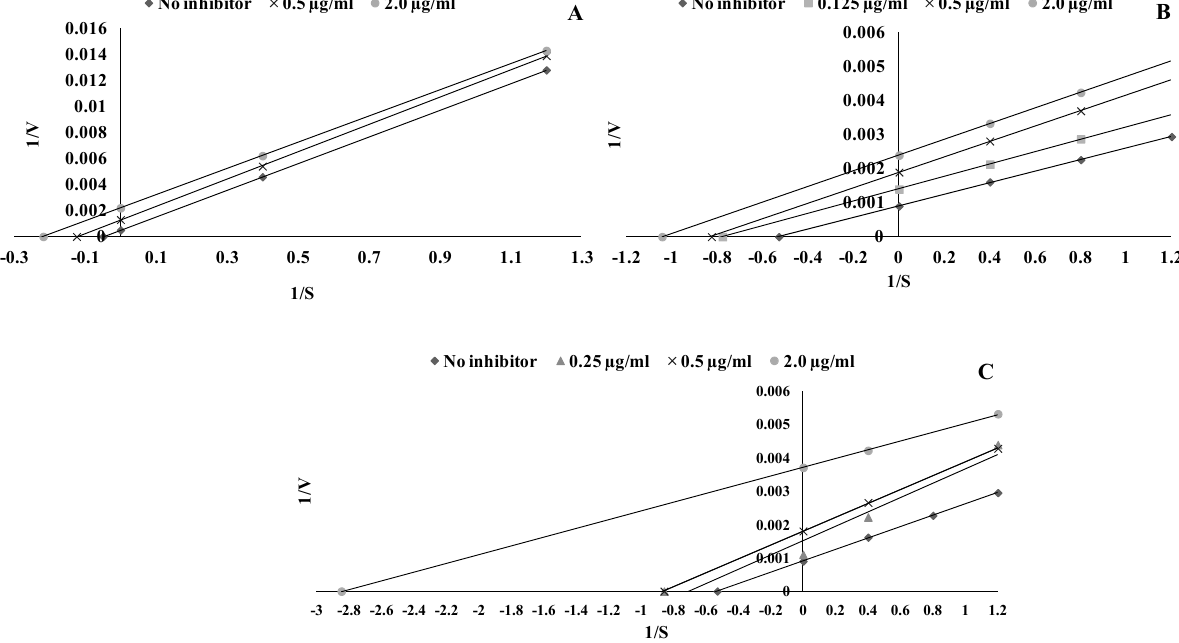
Figure 3. Lineweaver—Burk double reciprocal plots for the inhibition of lipoxygenase (LOX) by ferulic acid ( A ), syringic acid ( B ) and trans -cinnamic acid ( C ). Plots are expressed 1/velocity versus 1/linoleic acid [ µ g/mL] without or with inhibitors in a reaction solution. Table 2. Mode of inhibition, K i (K m without inhibitor), V max and IC 50 values of chosen phenolic acids on lipoxygenase (LOX) activity.